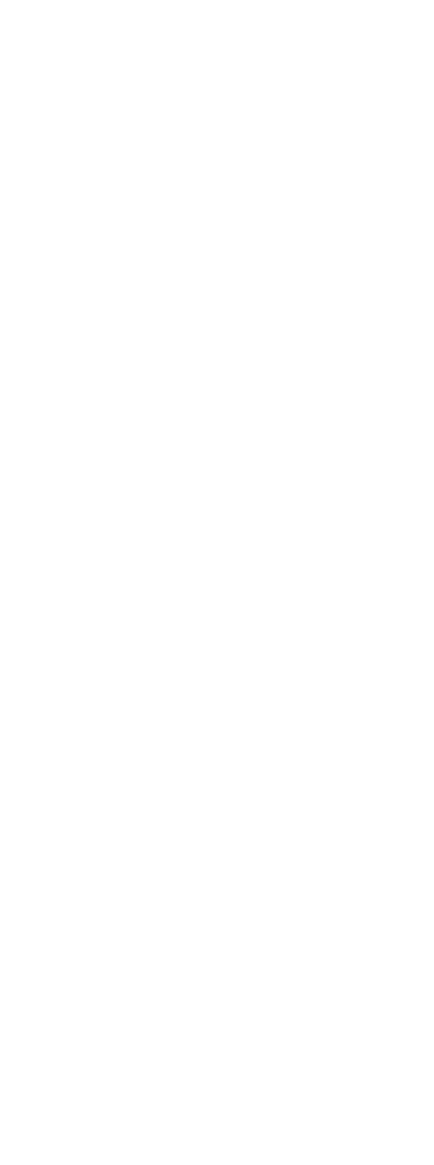
Figure 3 The evolution of a single path of I ( t ) for model (4) and its corresponding deterministic model (i.e., σ = 0 in (4)) with σ = 0.01,0.05,0.10,0.15, respectively. All other parameters are taken in (19). The initial value is I (0) = 10. The time unit is